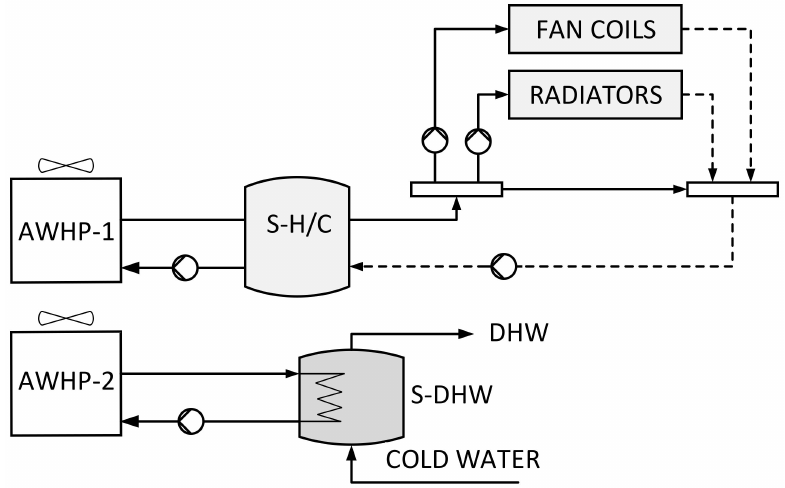
Figure 8. Scheme of HVAC system with AWHP